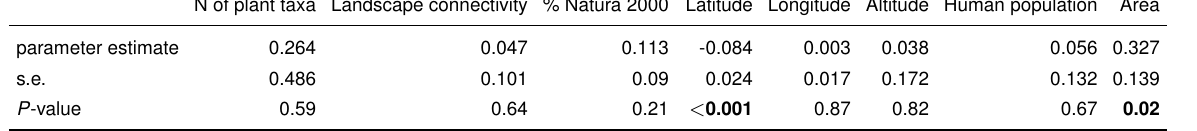
Table 1. Results of a General Linear Model for the proportion of agricultural land under organic farming in French Departments (2008) as a function of plant biodiversity, landscape connectivity, proportion of Natura 2000 protected areas, latitude, longitude, altitude, human population size and department area. The number of data points is 95, the adjusted R 2 of the model 0.50, and the intercept 1.457 (s.e. = 2.074). N of plant taxa Landscape connectivity % Natura 2000 Latitude Longitude Altitude Human population